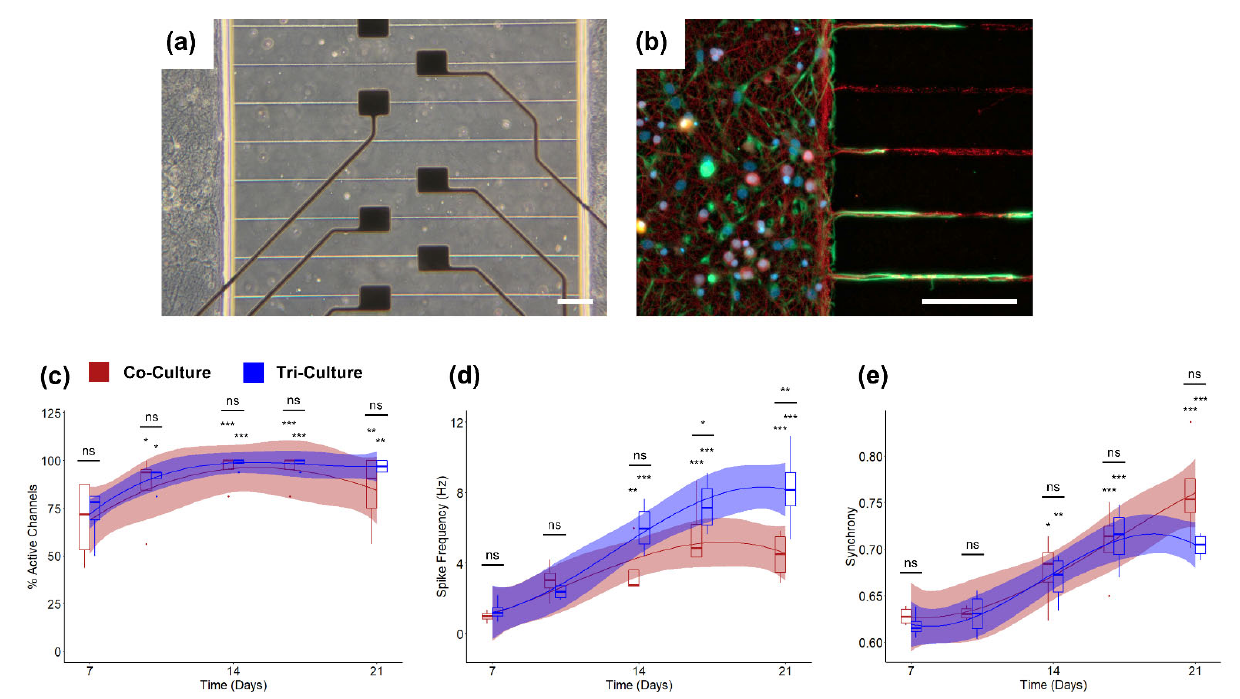
Figure 2. ( a ) Bright ‐ field and ( b ) epifluorescence images of the tri ‐ culture at DIV 21 in the platform MEA with microfluidic encapsulation. The cultures were immunostained for the three cell types of interest: neurons—anti ‐β III ‐ tubulin (red), astrocytes—anti ‐ GFAP (green), microglia—anti ‐ Iba1 (orange), and the general nuclear stain DAPI (blue). (Scale bar = 100 μ m). Comparisons of the ( c ) percent active channels, ( d ) spike frequency, and ( e ) synchrony between co ‐ cultures (red) and tri ‐ cultures (blue) cultured in a two ‐ chambered microfluidic device. The solid lines show the fitted linear mixed effects model (treating individual cultures as a random effect) with a b ‐ spline basis. The shaded regions are the 95% confidence interval. An asterisk above an individual box indicates a significant difference of the estimated marginal means of the fitted curves between that timepoint and DIV 7 of the same culture type, while the bars indicate the significance between the co ‐ and tri ‐ culture at that timepoint ( n = 5, from two independent dissections). * p < 0.05, ** p < 0.01, *** p < 0.001, ns indicates no significant difference.